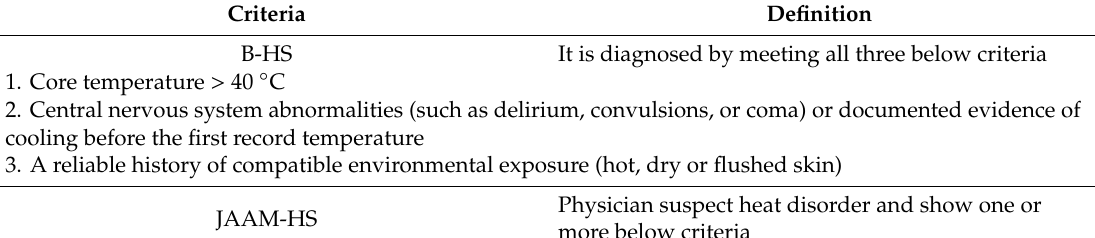
Table 1. Diagnostic criteria for the B-HS and JAAM-HS